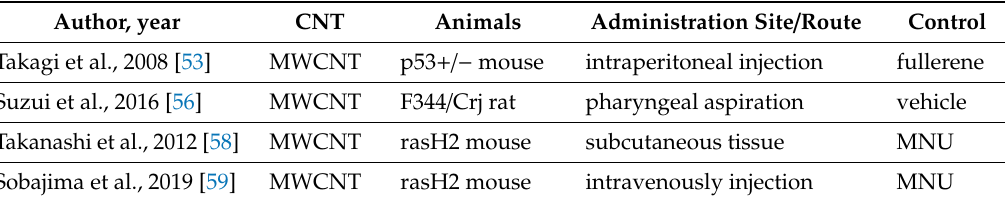
Table 5. Carcinogenicity testing of CNTs.